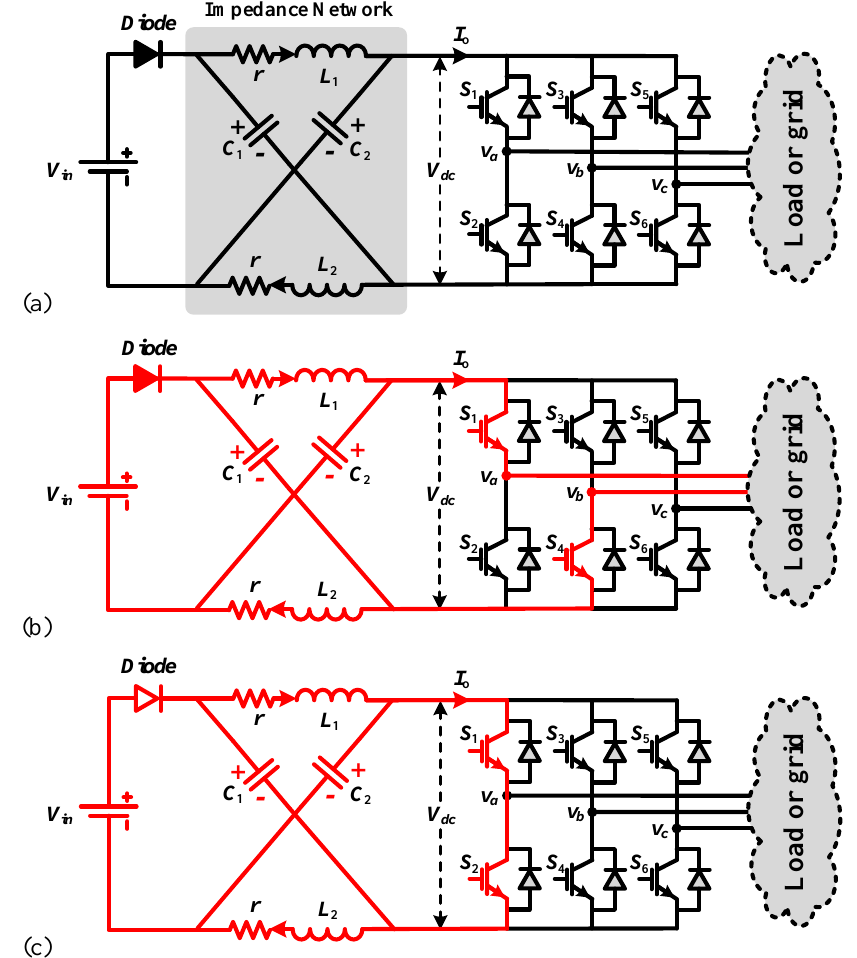
Figure 1. A voltage-source ZSI in ( a ) passive ( b ) non-shoot-through ( c ) shoot-through